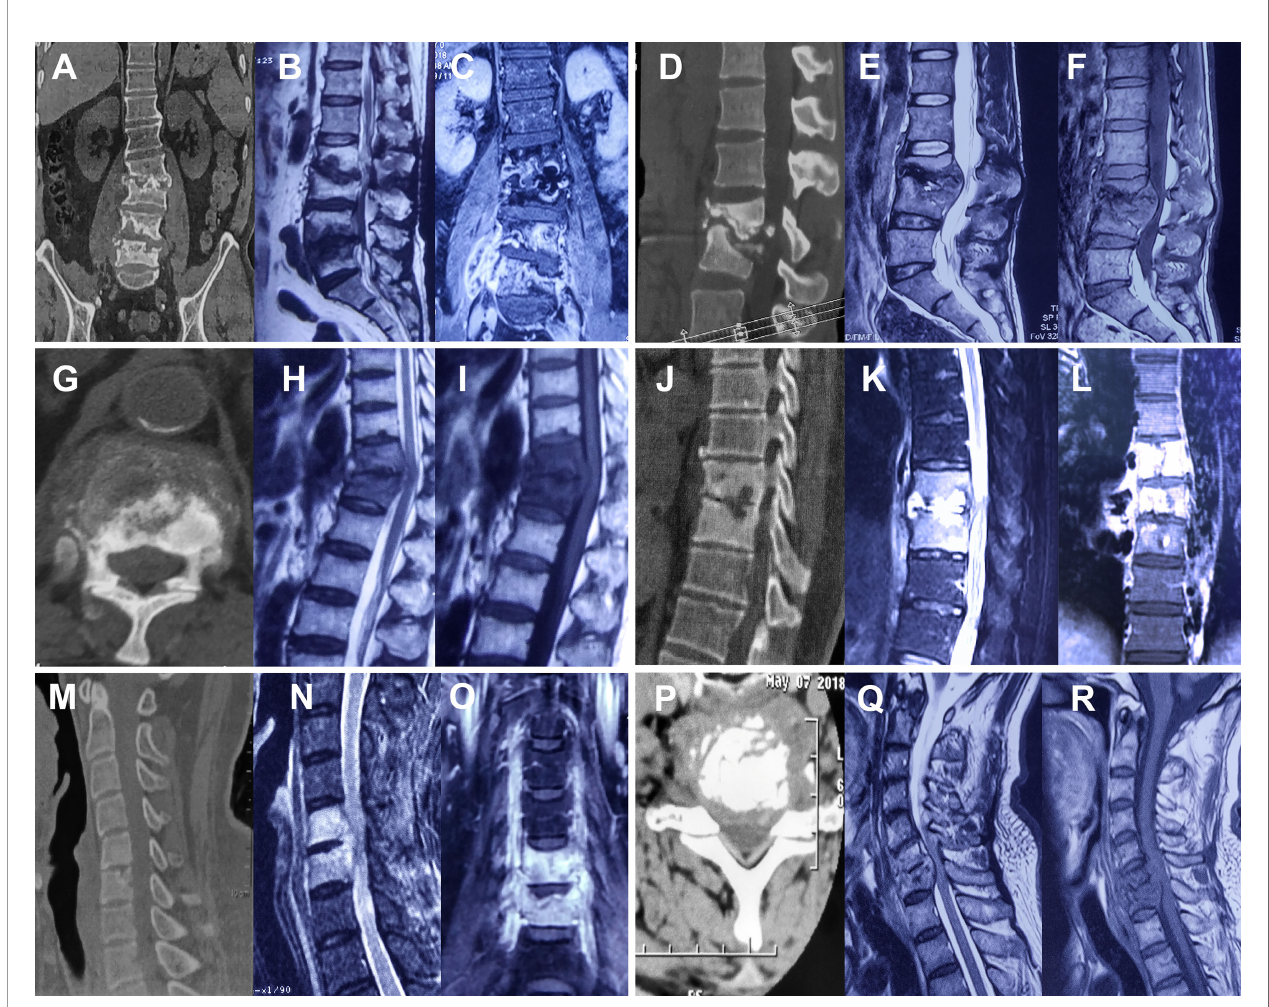
FIGURE 1 | Typical spinal tuberculosis cases. Marginal erosions, bone destruction, soft tissue infection (abscesses), and spinal cord compression were shown on CT or MRI images. (A – F) Typical lumbar tuberculosis. (G – L) Typical thoracic tuberculosis. (M – R) Typical cervical